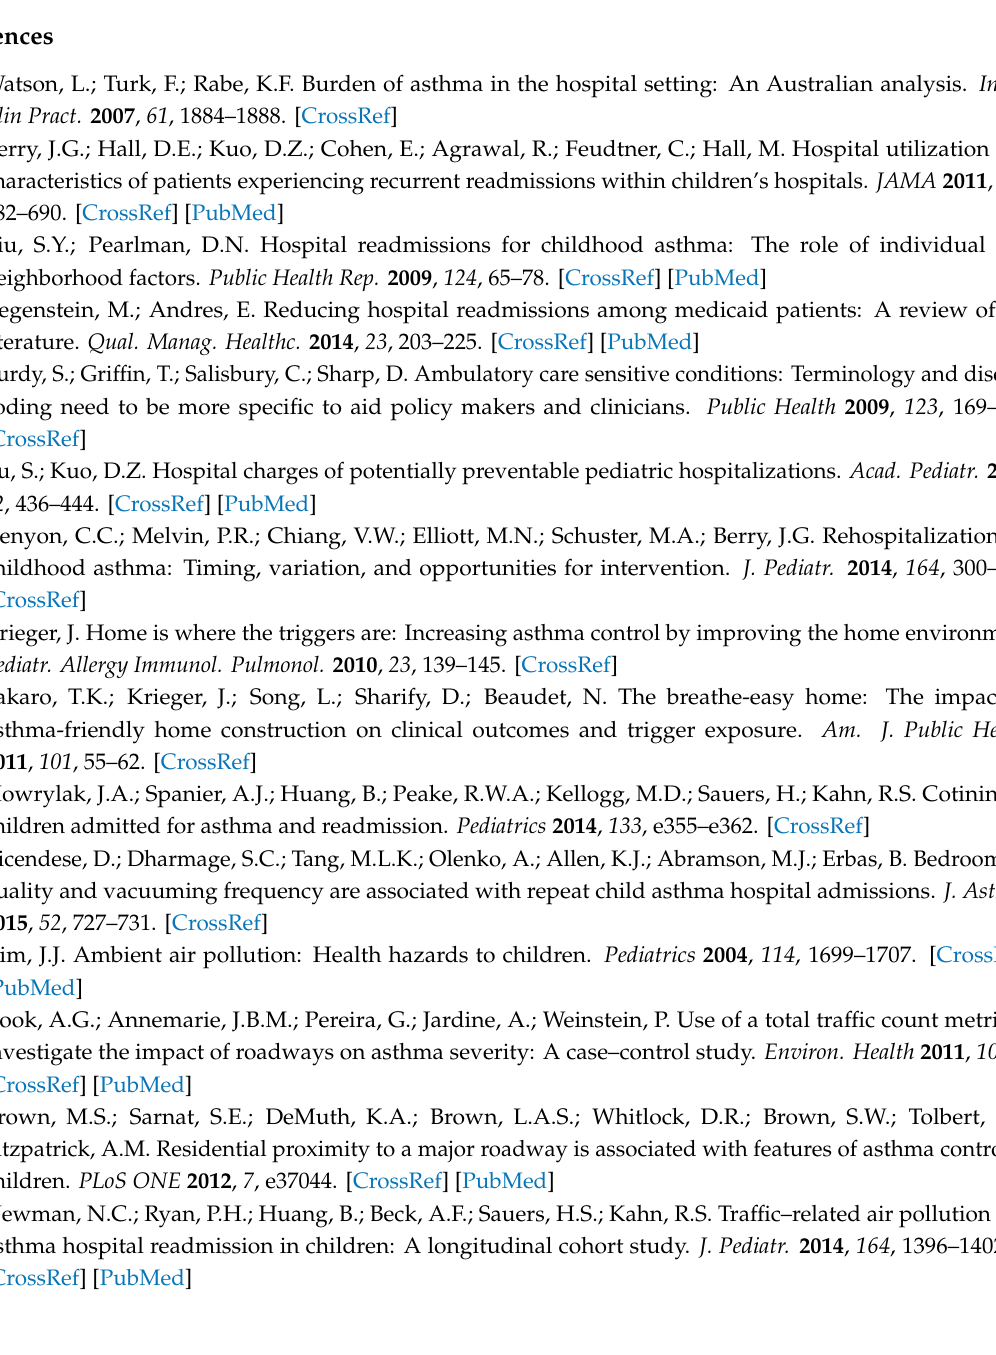
Note: significant at p < 0.05